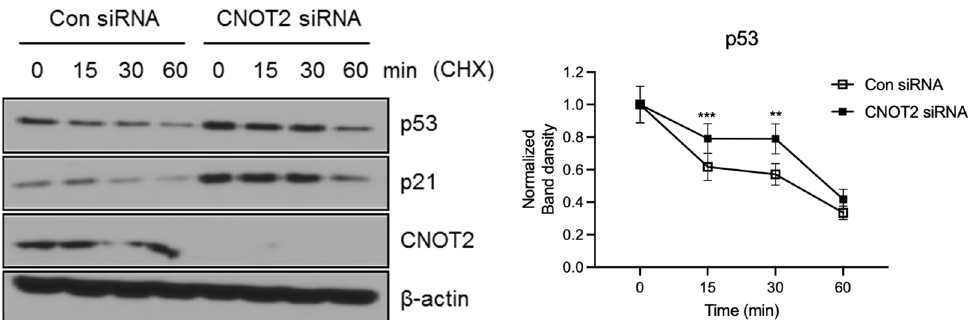
Figure 3. CNOT2 knockdown inhibits p53 degradation. p53’s half-life was increased by CNOT2 knockdown in HCT116 p53+/+ cells. HCT116 p53+/+ cells were transfected with CNOT2 or scrambled siRNA and collected 72 h after transfection for Western blotting with indicated antibodies. * p value indicates a significant difference between the groups ** p < 0.01, *** p < 0.005.